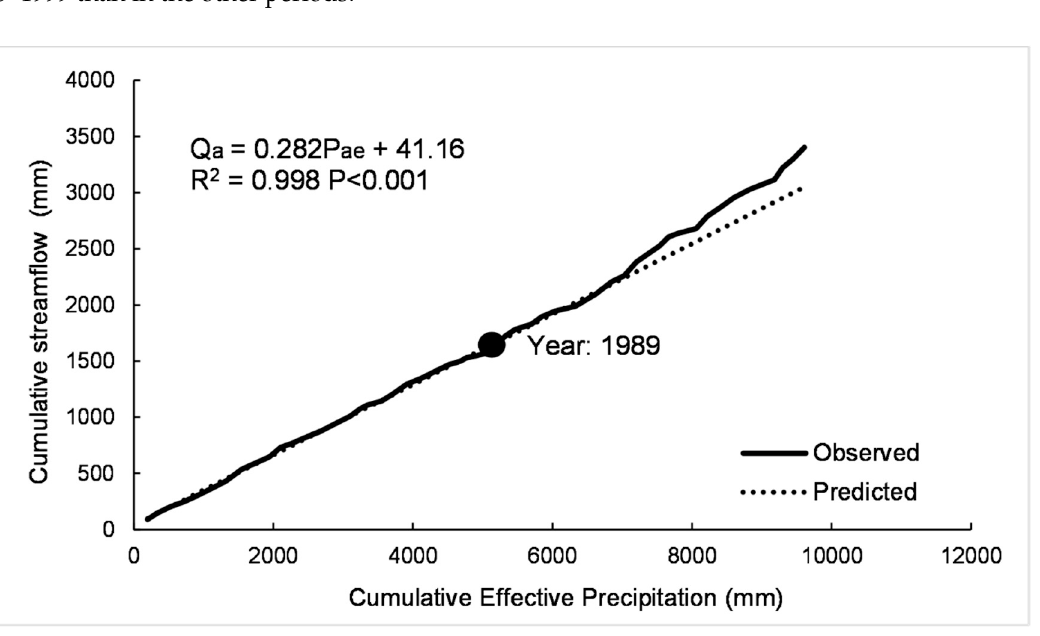
Figure 4 : Modified Double Mass Curve (MDMC) of cumulative effective precipitation (P ae ) versus cumulative annual mean flow (Q a ) in the Deadman River watershed from 1960 to 2012. The ‘Predicted’ line is from the linear equation shown on the graph. The breakpoint is in 1989.